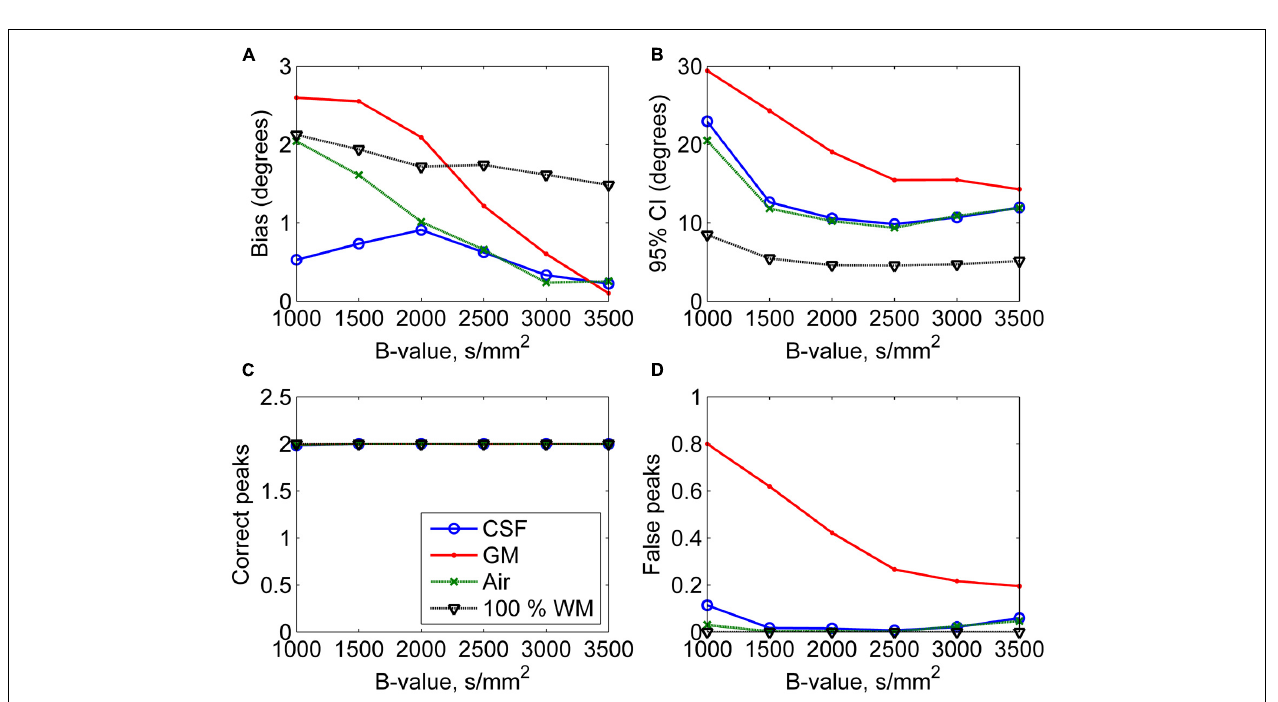
FIGURE 4 |The effect of varying diffusion weightings with 50% non-WM partial volume (CSF, GM, and air) to bias (A), 95% confidence interval (CI) (B), and the number of correct (C) and false peaks (D) estimated with CSD (with up to eighth-order SH, angle 70 ◦ , and SNR 30). For comparison, 100%WM measures are